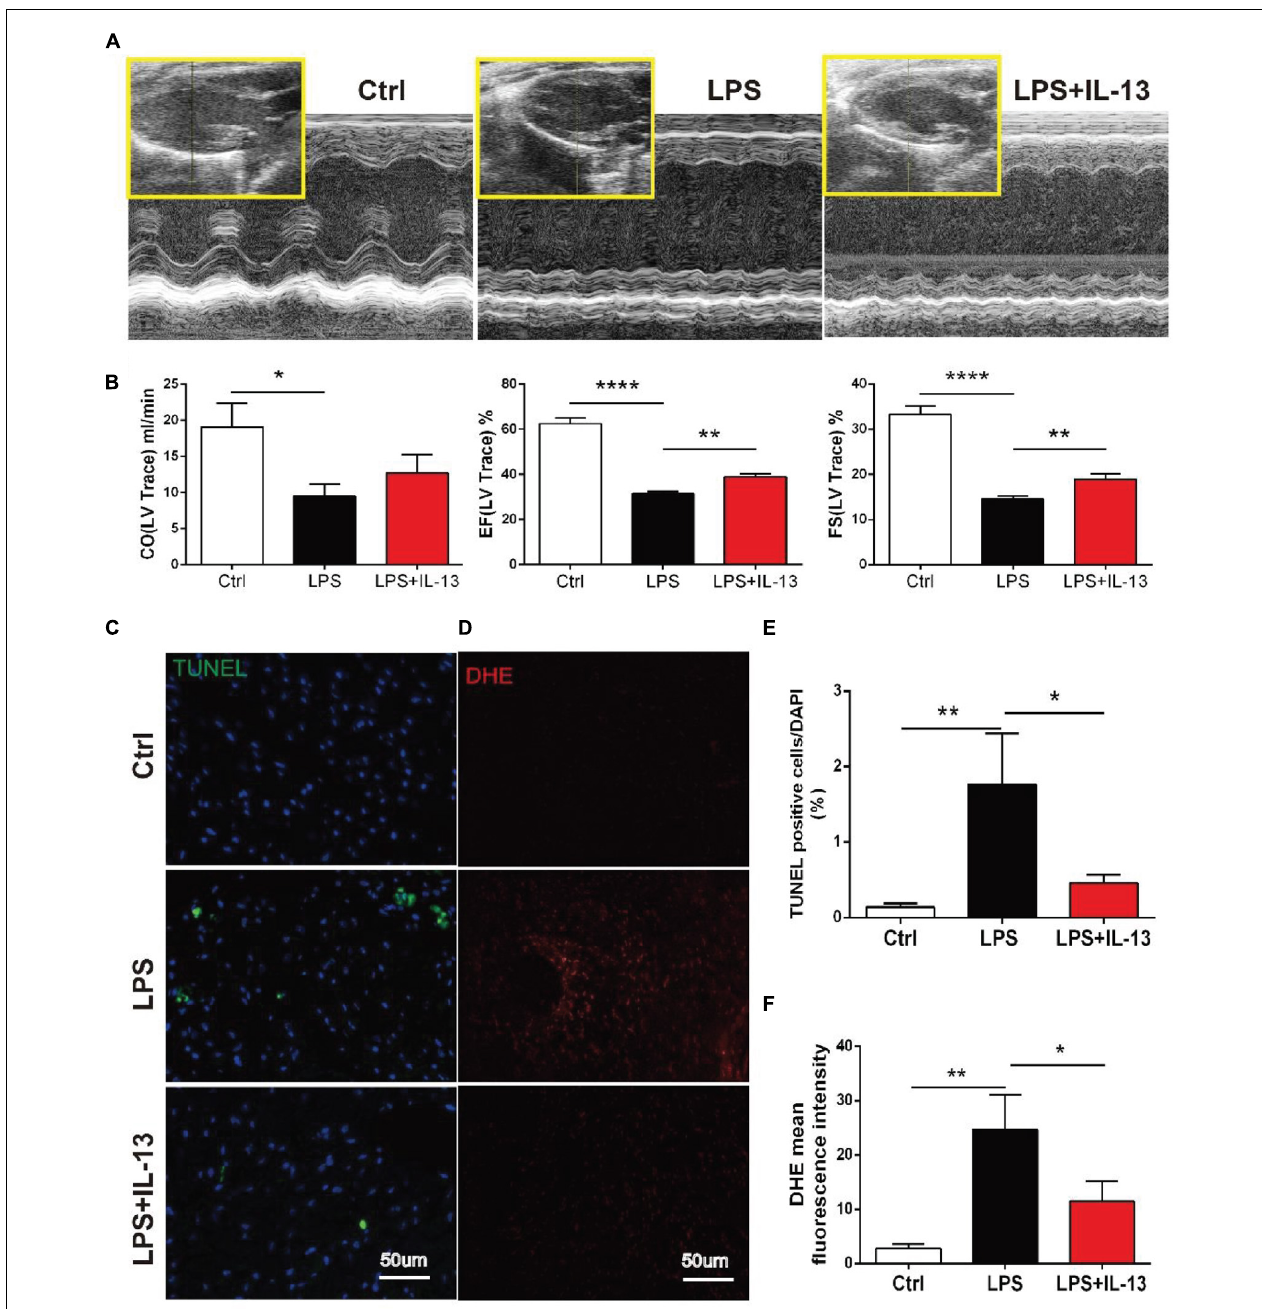
FIGURE 2 | IL-13 alleviated LPS-induced cardiac dysfunction and reduced apoptosis in mice. (A) Representative images of M-mode echocardiography. (B) Quantification of cardiac output (CO), ejection fraction (EF) and fractional shortening (FS) by echocardiography. (C) Representative TUNEL staining in the cardiac tissue, Scale bar = 50 µ m. (D) Representative images of dihydroethidium (DHE) in the cardiac tissue, Scale bar = 50 µ m. (E) Percentage of TUNEL-positive nuclei. (F) DHE oxidation values represent the mean fluorescent intensity (MFI). Data were expressed as the mean ± SD ( n = 6). * p < 0.05, ** p < 0.01, **** p < 0.0001.